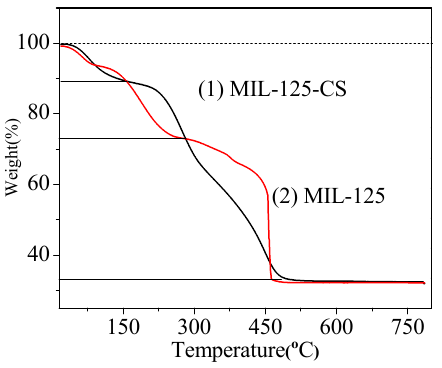
Figure 4. TGA curves of (1) MIL-125-CS and (2) MIL-125.